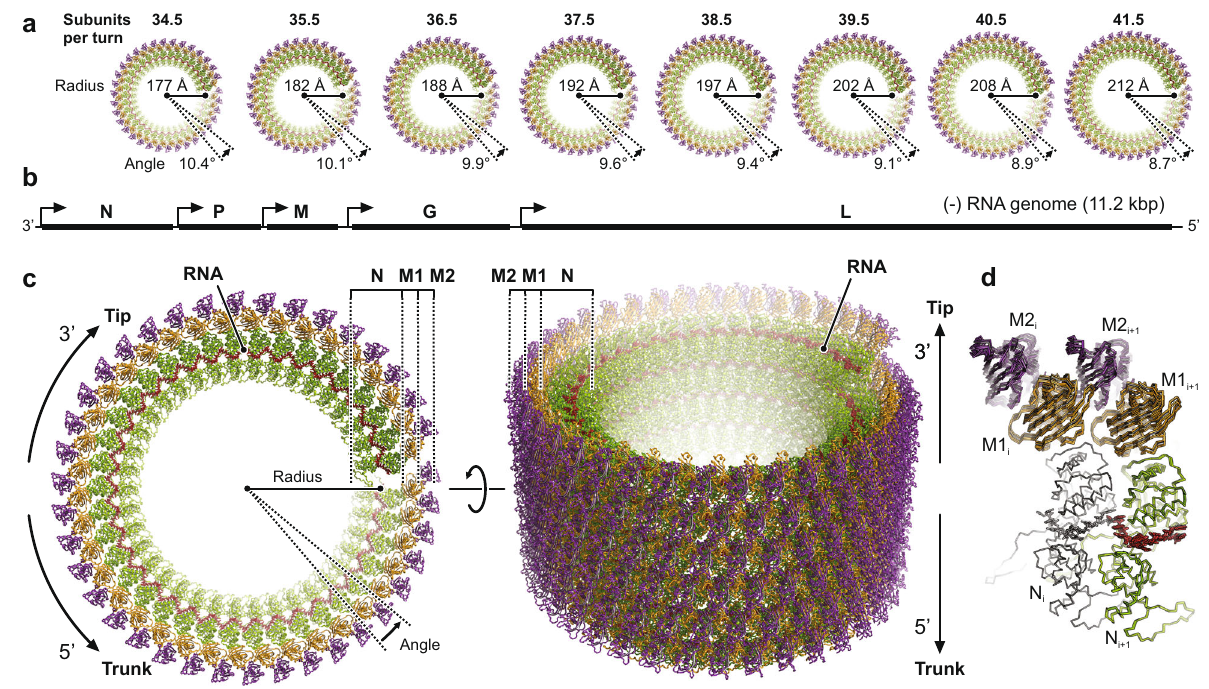
Fig. 2 | Structure of the helical VSV nucleocapsid. a Top views of the helical nucleocapsids from virions with different numbers of subunits per turn. The nucleoprotein (N) is colored green, the RNA red, and the two matrix proteins (M1 and M2) are colored orange and purple, respectively. b Schematic organization of theVSVnegative-strandgenomicRNA.Openreadingframesencodingthe fi veviral proteinsareindicatedbysolidblacklines.Transcriptionstartsitesareindicatedby arrows.The3 ′ endofthesingle-strandedRNAterminatesatthetipofthevirion,the